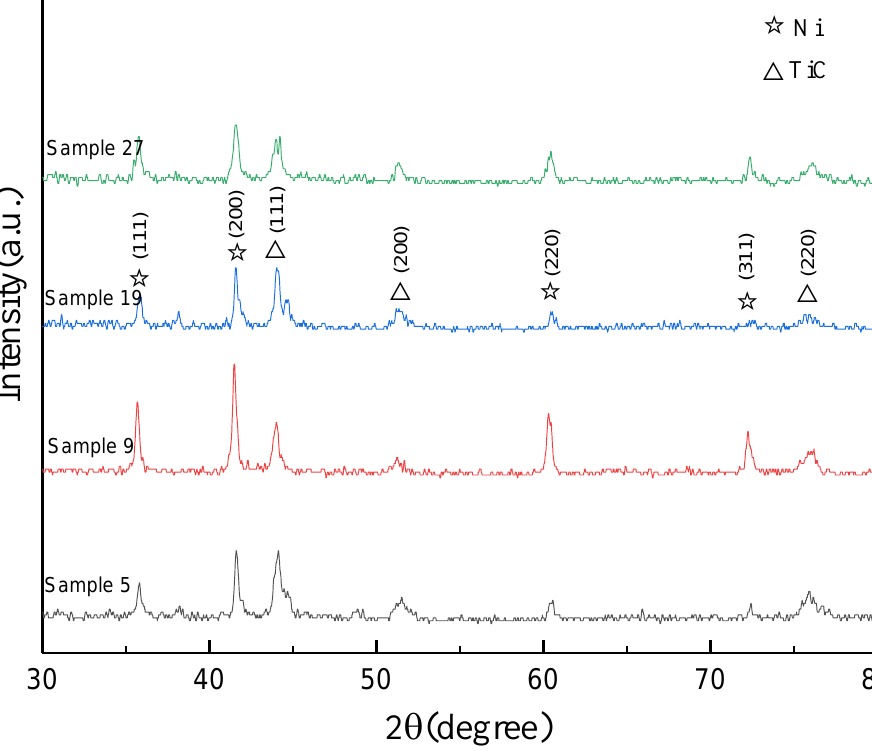
Figure 14. XRD patterns of different samples.